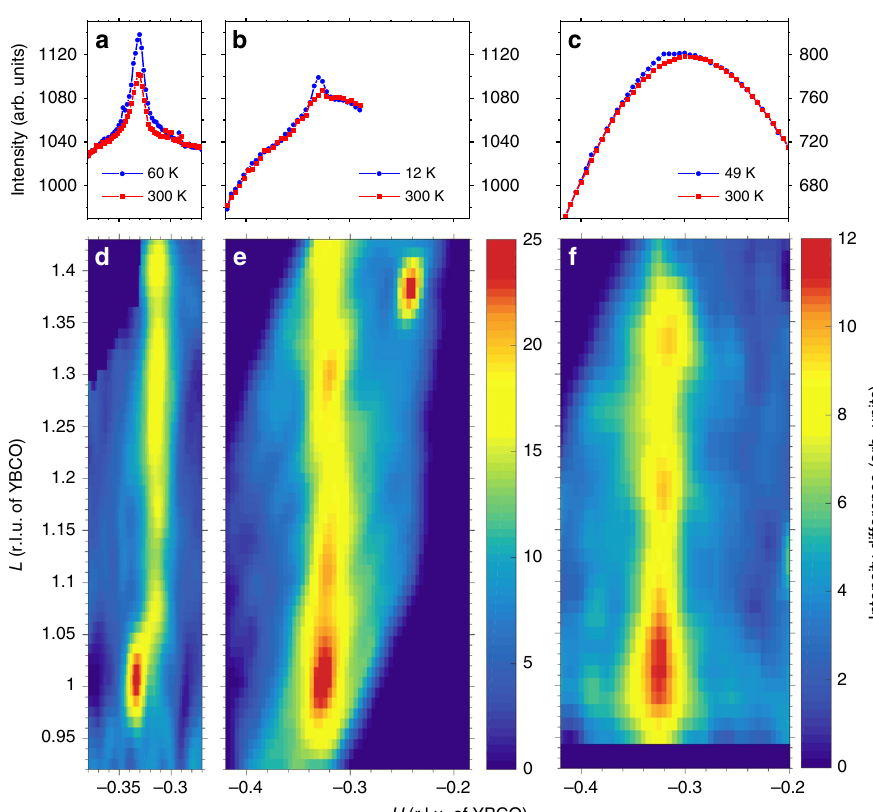
Fig. 1 Reciprocal space mapping. Three YBCO fi lms grown on STO (001) are studied; a , d 50 nm, T c = 53 K; b , e 50 nm, T c = 55 K; c , f 20 nm, T c = 53 K. Scattering data were collected using σ polarized photons tuned to the Cu L 3 -absorption edge. Panels a – c show the high and low temperature scattering intensity along the reciprocal space direction ( H 0 1). Panels d – f exhibit reciprocal space maps in the H − L plane, these are produced by subtracting the scattered intensity detected at 300 K from the equivalent map measured at low temperature. The color maps were smoothed using a Gaussian fi